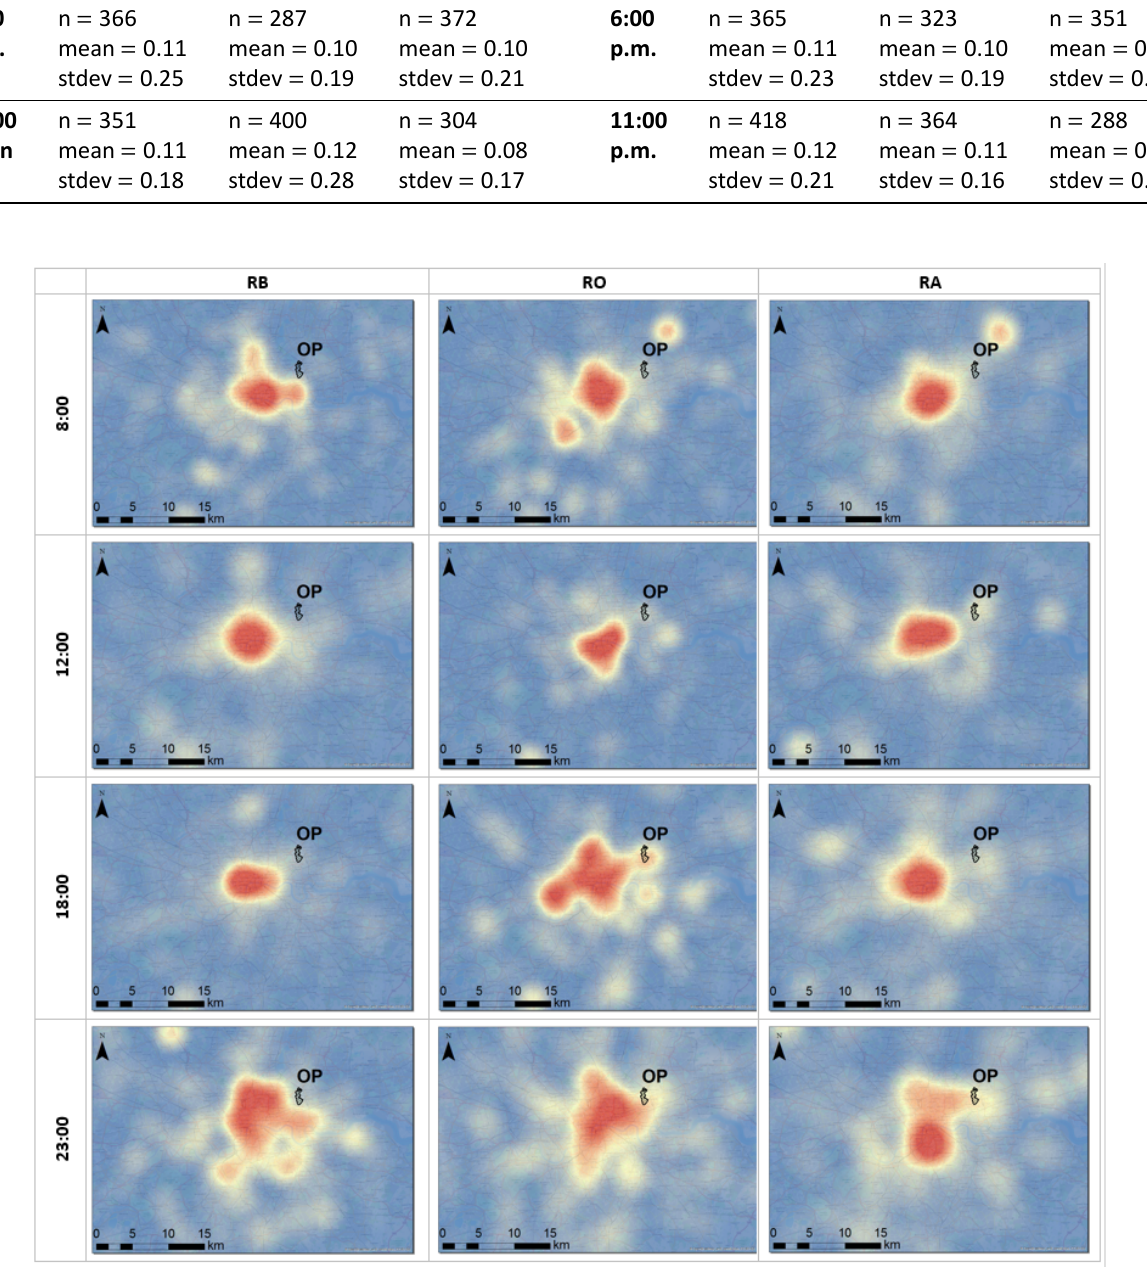
Figure 1. Hot spots of residents’ negative tweets for specific